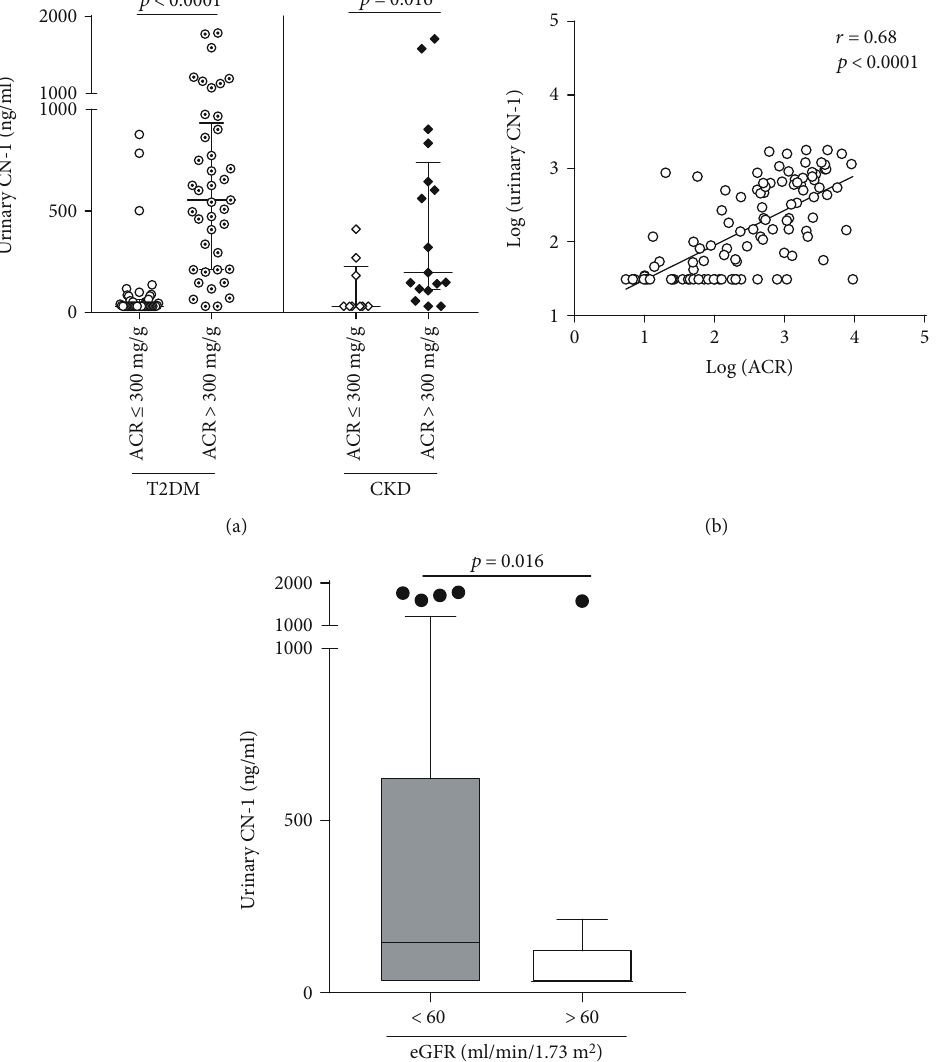
nondiabetic group with macroalbuminuria ( p = 0 : 05 ) (data not shown). In the overall population of patients ( n = 111 ), a positive correlation between urinary CN-1 and ACR was found ( r = 0 : 68 , p < 0 : 0001 ) (Figure 1(b)). Patients with reduced renal function ( eGFR < 60 ml/min/1 : 73m 2 ) were found to have signi fi cantly higher urinary CN-1 concentrations com- pared to patients with preserved renal function ( eGFR > 60 ml/min/1 : 73m 2 ) ( p = 0 : 015 ) (Figure 1(c)). When three eGFR strata ( eGFR < 30 , 30-60, and > 60 ml/min1.73m 2 )